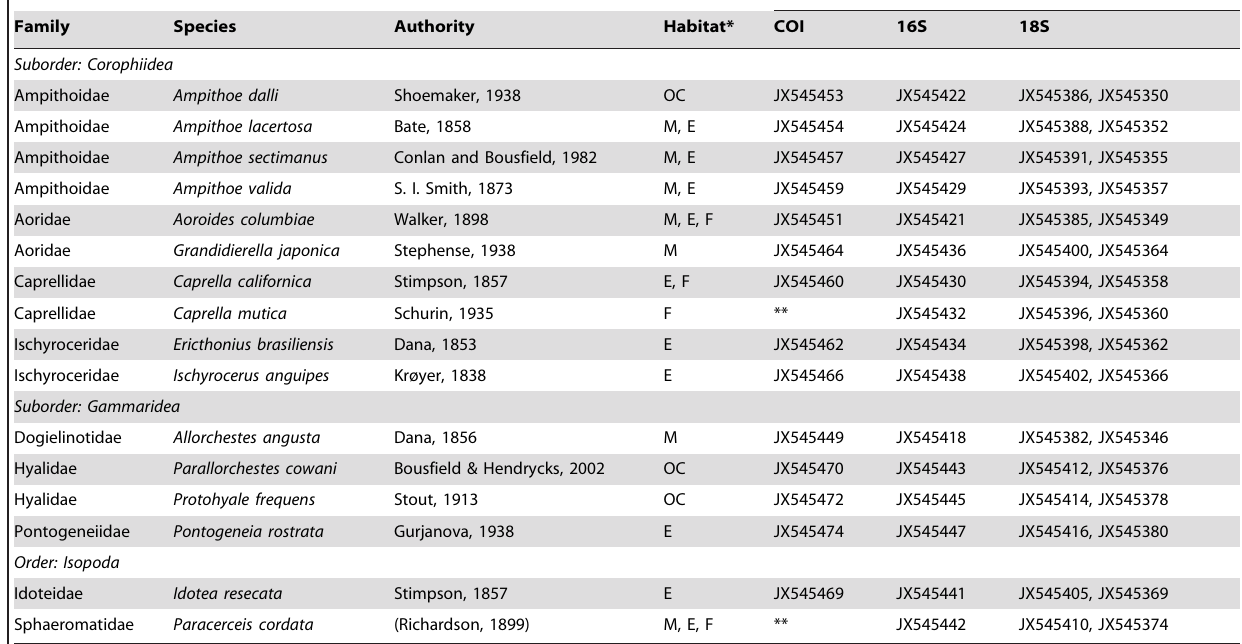
Table 1. Species included in the study.